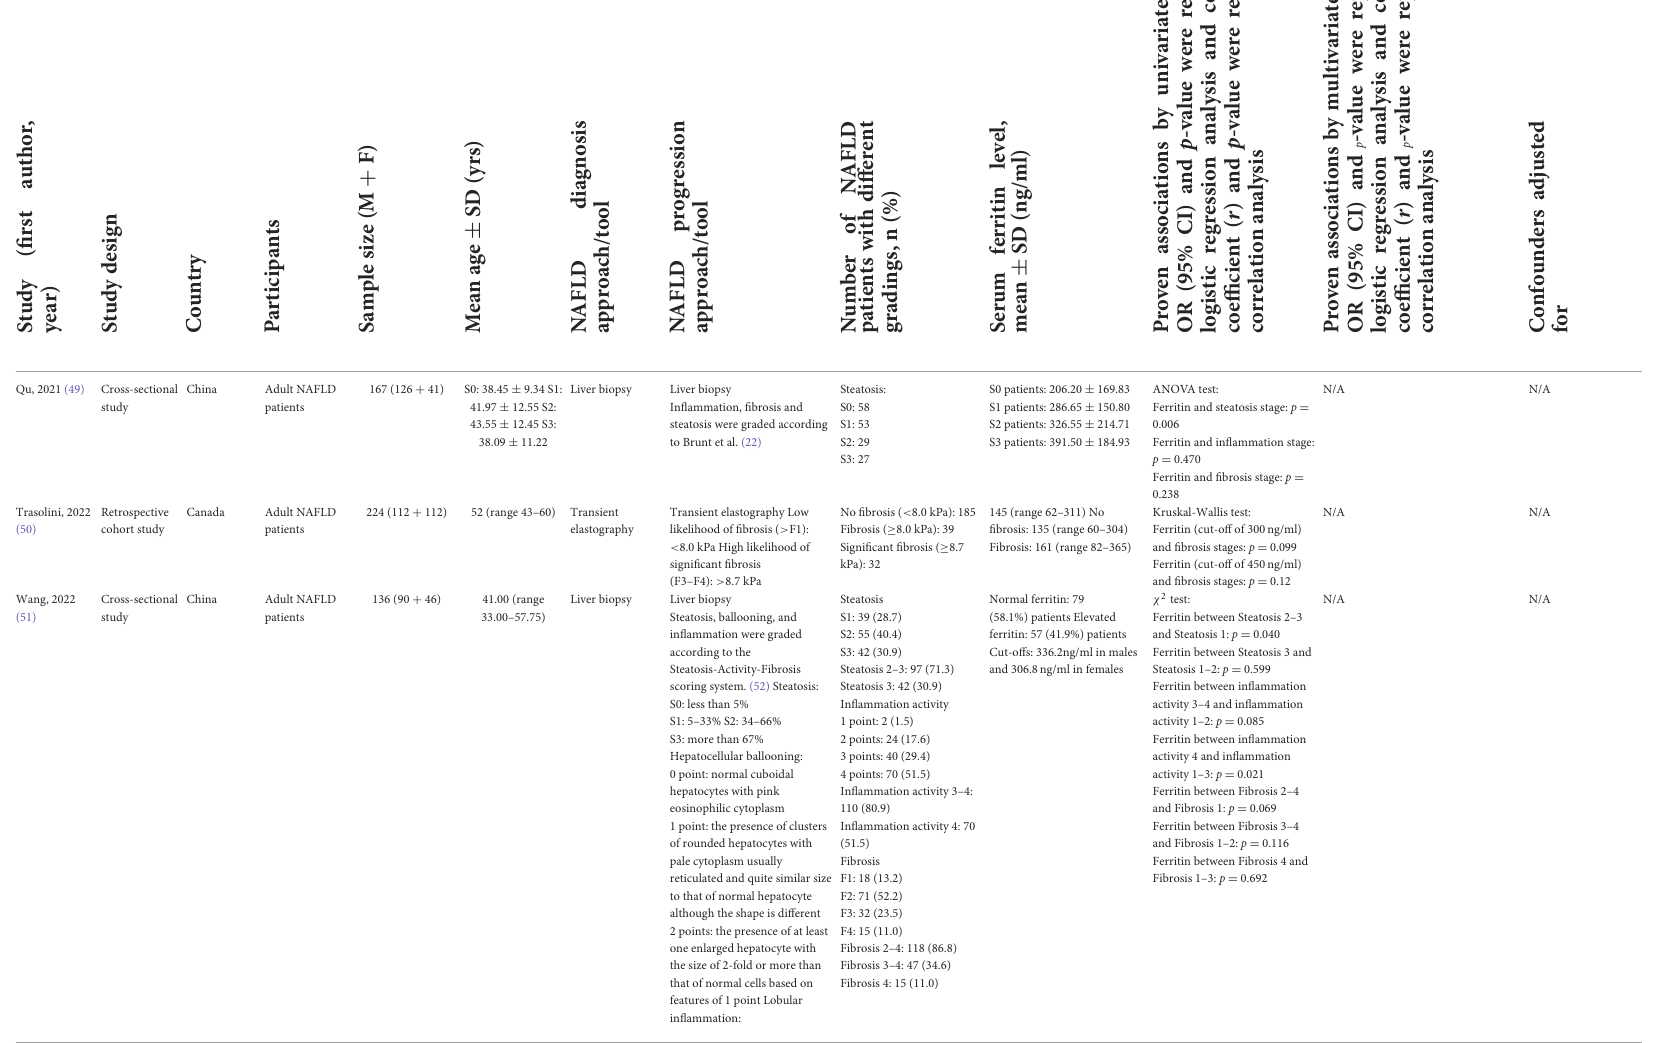
and306.8ng/mlinfemales